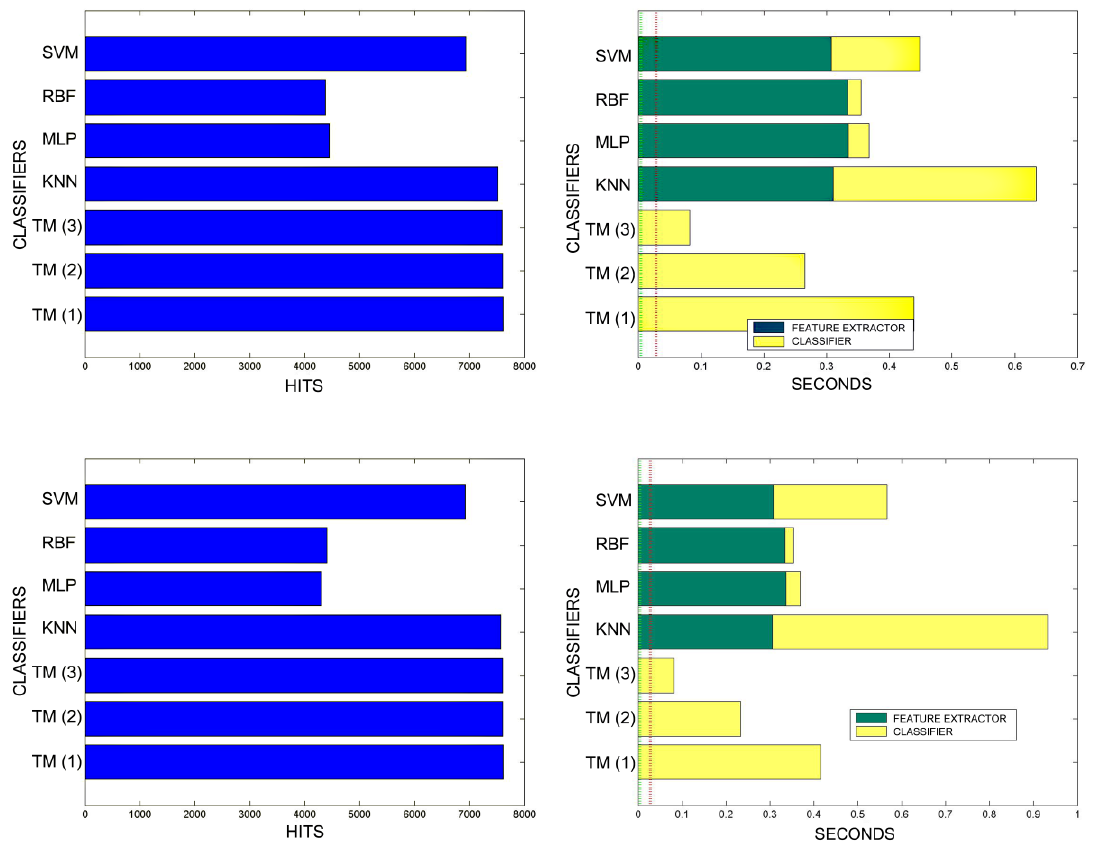
Figure 19. Comparison of successful matches on the left, in blue, and time taken for classification on the right, feature extractor in green, and classification in yellow. In descending order, the training sets represent 10% and 20% of the total training samples.